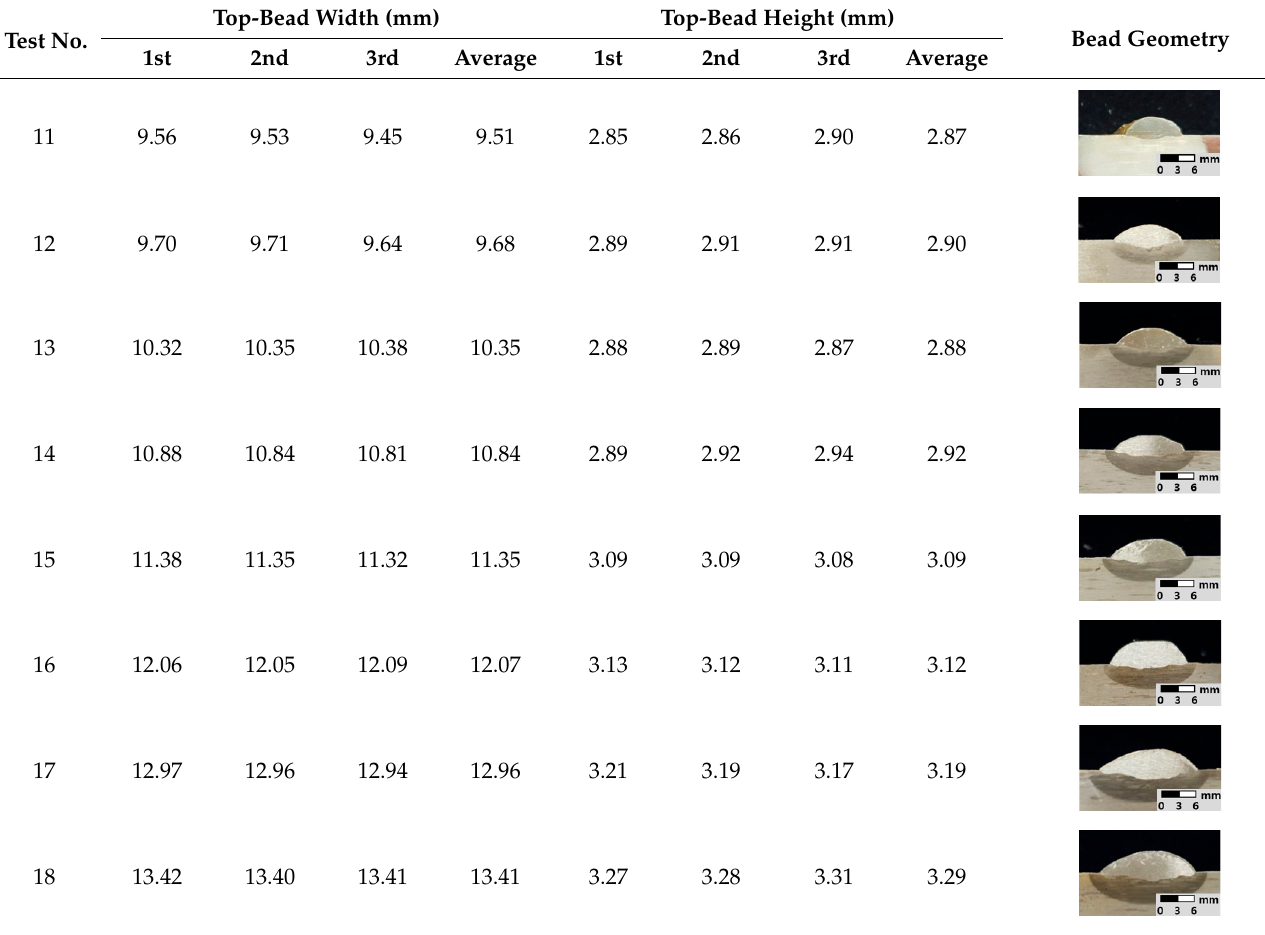
Figure 4. Schematic diagram of the hardness test. Table 6. Results of hardness according to welding process and parameters. Test No.